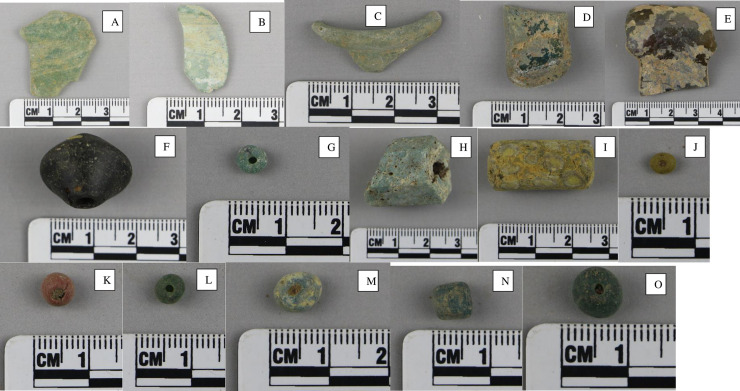
Examples of glass vessels and glass beads from Malindi and Mambrui.(A) A fragment of a glass bowl (G01) from Malindi; (B) A fragment of glass vessel (G03) from Malindi; (C) Rim of a bottle (G14) from Malindi; (D) The base of a small phial (G18); (E) The base of a glass bowl (G20); (F) A truncated bicone from Malindi (B04); (G) An opaque turquoise oblate bead (B28); (H) An octagonal rectangular prismatic bead (B41); (I) An opaque yellow tubualr bead (B42); (J) An opaque yellow oblate bead (B45); (K) A brownish red spheroid bead (B50); (L) A green tubular bead (B52); (M) A light green oblate bead (B59); (N) A green tubular bead (B60); (O) A green oblate bead (B64).